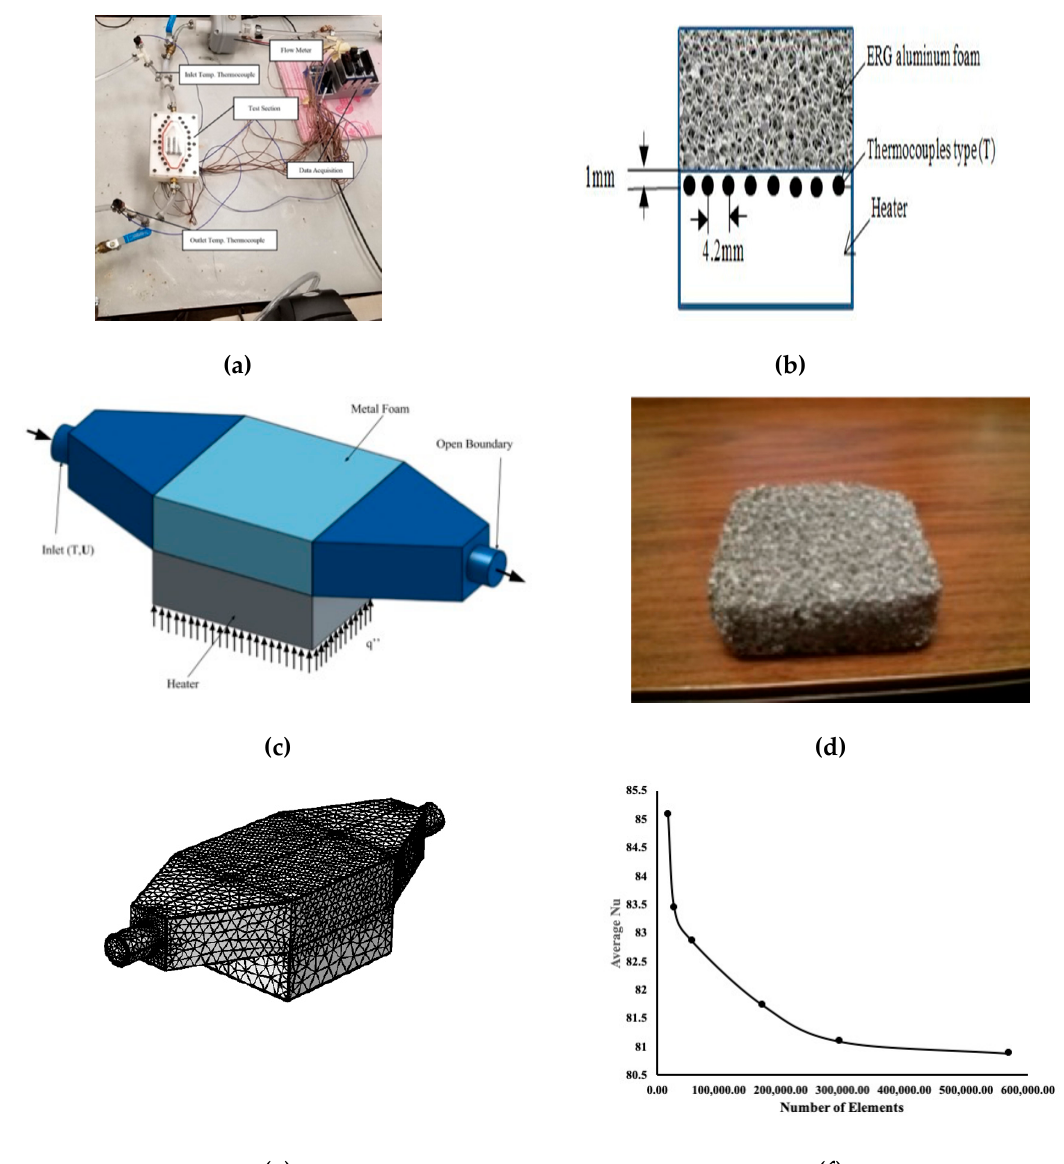
Figure 1. Experimental and numerical setup. ( a ) Experimental setup, ( b ) Location of the thermocouple, ( b ) Location of the thermocouple, ( d ) Metal foam block, ( e ) Finite element model, ( f ) Mesh sensitivity.